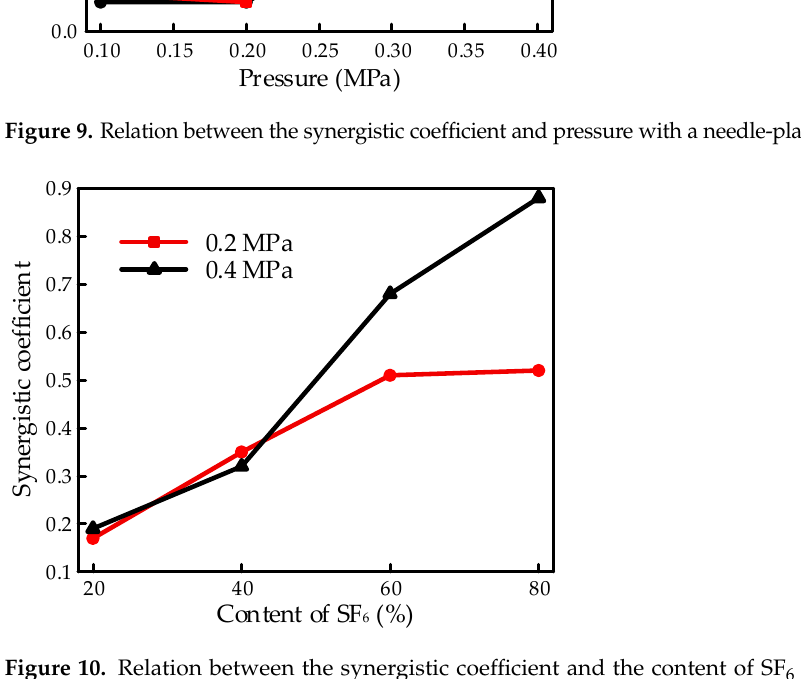
electrode trode system.